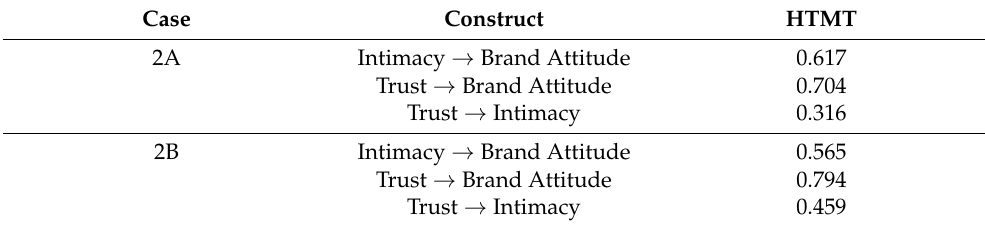
Table A6. Discriminant Validity of each case in Public Transportation Service